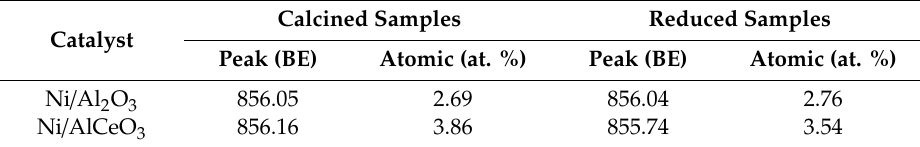
Table 2. Ni2p XPS data of calcined and reduced Ni / Al 2 O 3 and Ni / AlCeO 3 catalysts.